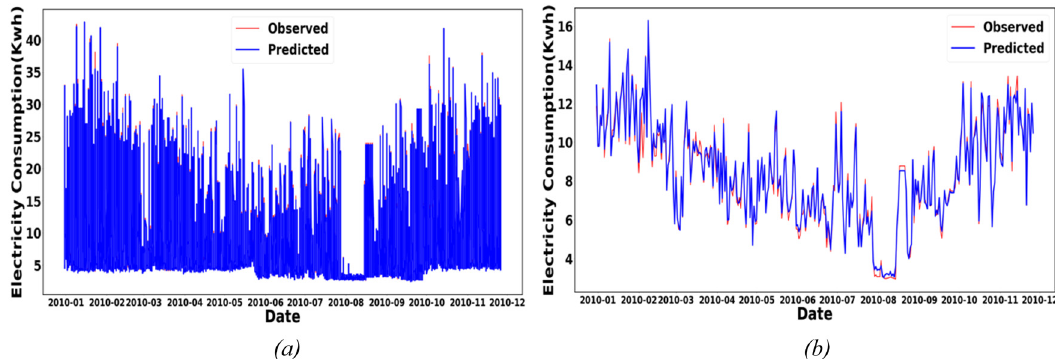
Figure 11: Household prediction vs original observations after XGBoost hyperparameters tuning resampled to: ( a ) hourly granularity, and ( b ) daily granularity.